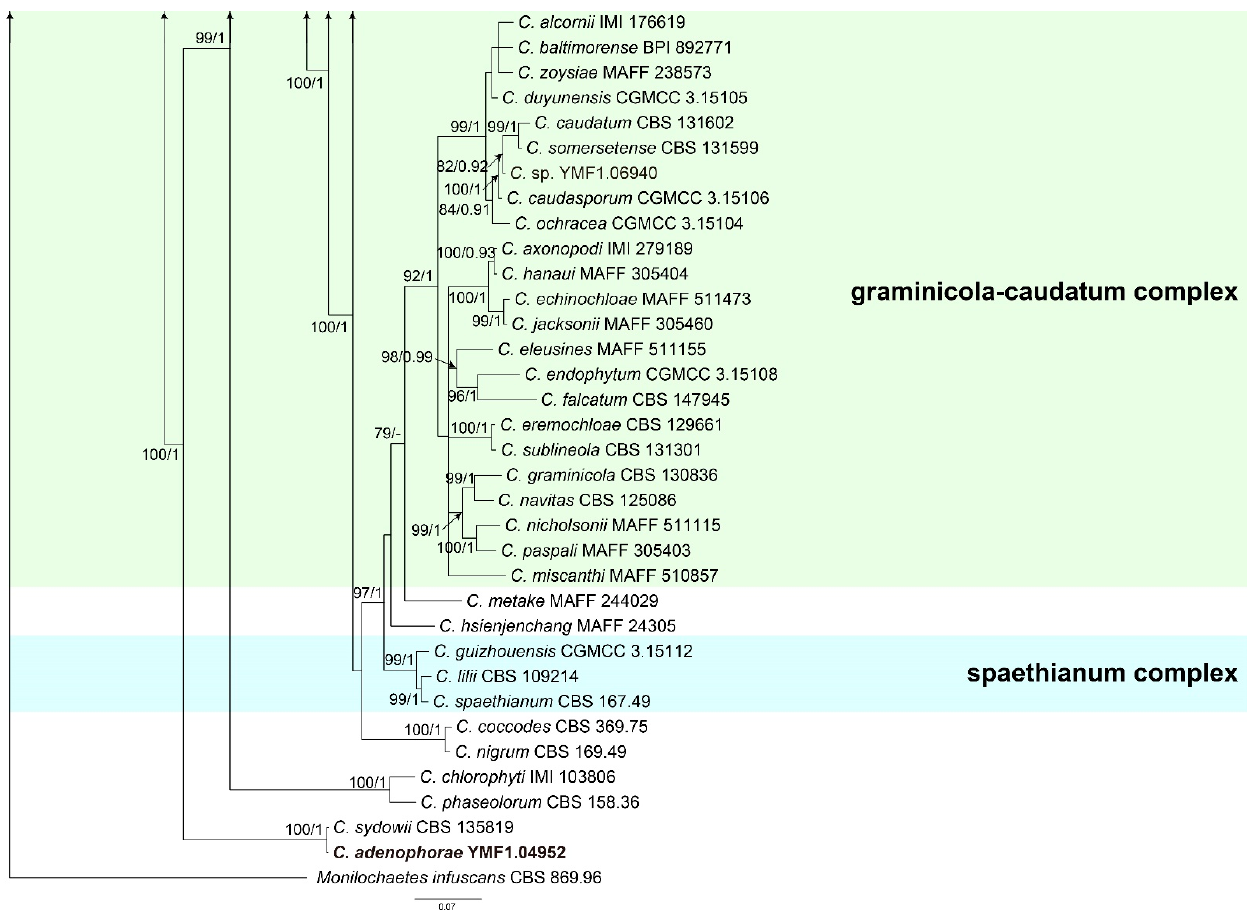
Figure 1. Phylogenic tree generated by the maximum likelihood analysis using combined sequences of ACT, CHS-1, GAPDH, ITS, and TUB2 loci of the genus Colletotrichum . Bootstrap values ≥ 70 (left) and Bayesian posterior probability values ≥ 0.9 (right) are indicated at nodes (MLBP/BIBP). Monilochaetes infuscans CBS 869.96 was used as the outgroup. Novel species generated in this study are indicated in black bold.